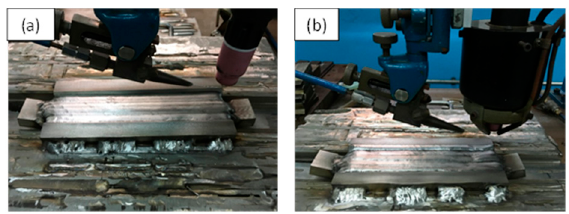
Figure 2. Welding equipment: ( a ) GTAW and ( b ) GTAW+EMS.